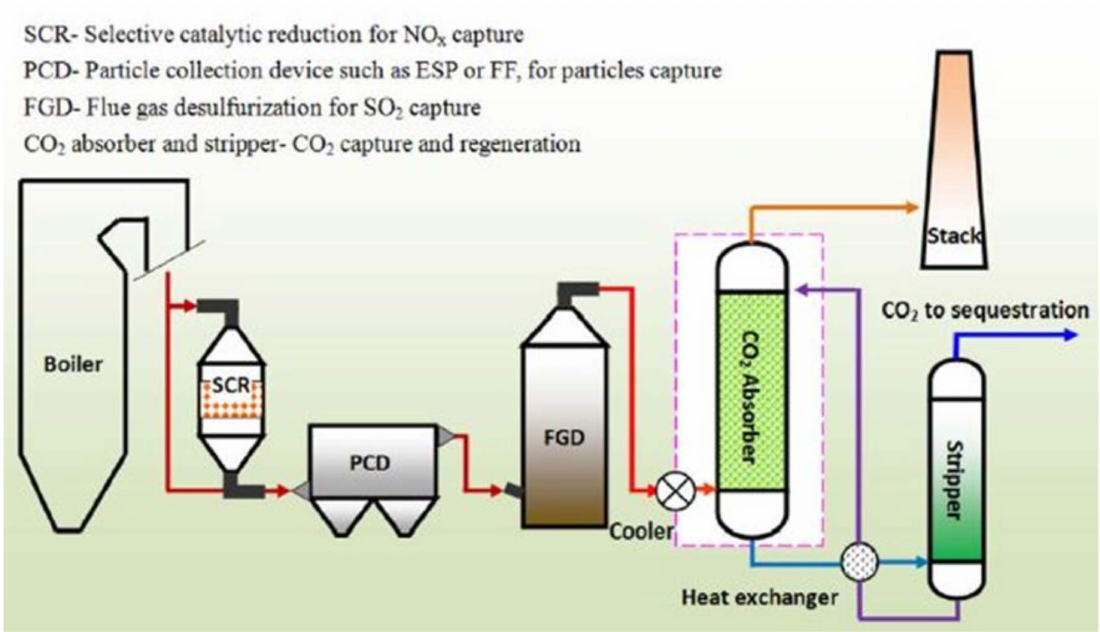
Figure 7. Capturing of carbon dioxide using aqueous ammonia [149], reproduced with Permission No.